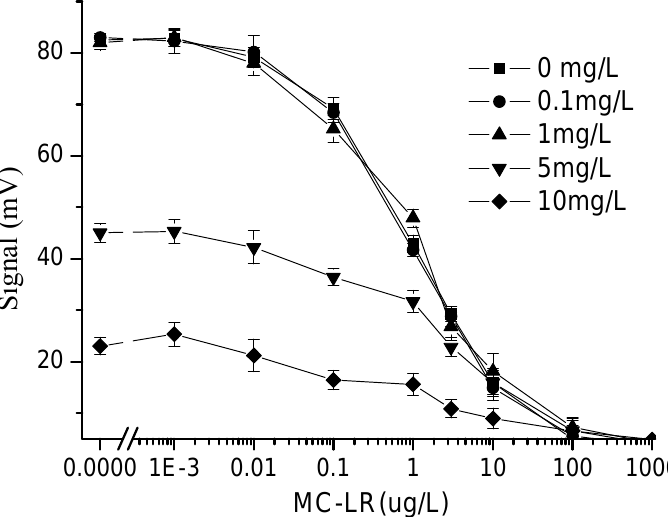
Figure 3. Effect of the copper ions on the MC-LR immunoassay based on EWAI (not containing EDTA in immunoassay system). The concentration of CuSO 10